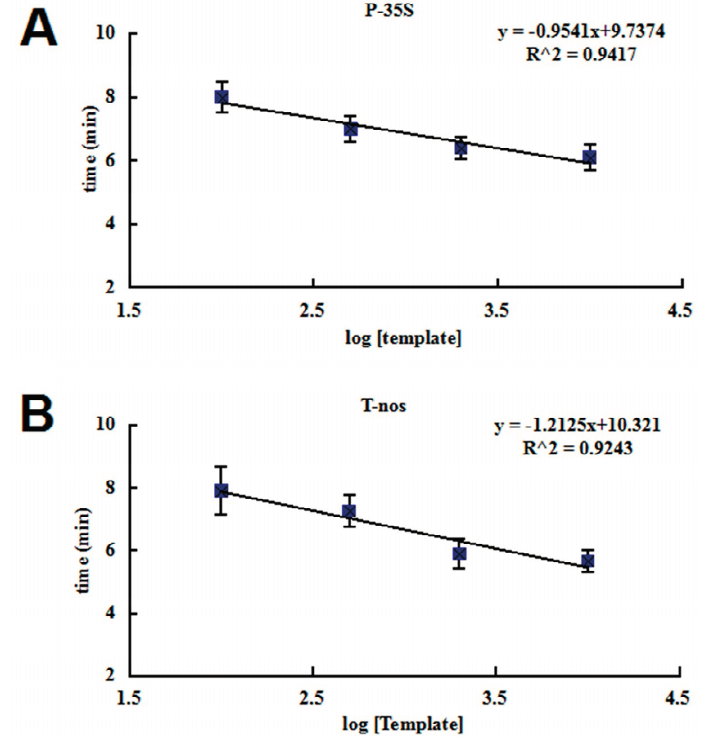
Figure 2. Calibration curves for ( A ) P-35S and ( B ) T- nos . Standard curves calculated from the data (shown in Table 3) from 6 runs at 4 concentrations. The x -axis represents the logarithm of the estimated copy number of the calibrant, and the y -axis represents the threshold time value.